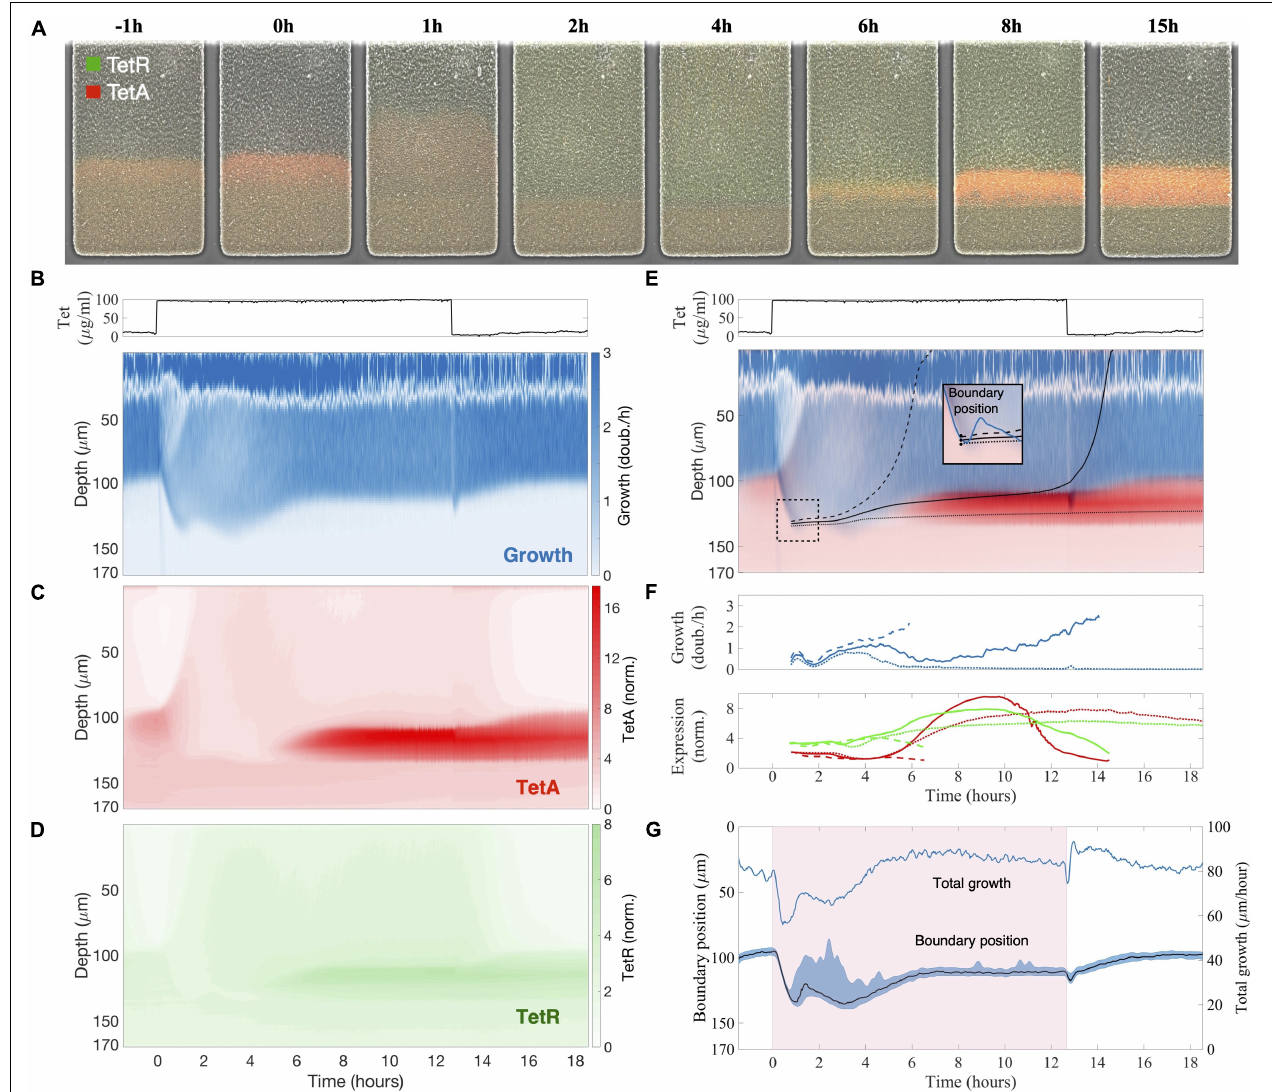
FIGURE 2 | Sudden exposure to tetracycline causes a reorganization of growth and expression patterns across the microcolony. (A) Images of the colony during a response to sudden exposure to tetracycline at time zero, with expression of repressor TetR shown in green and efflux pump TetA shown in red. Following exposure, growth arrest of cells near the surface makes nutrients available deeper into the trap, so the boundary between growing and arrested cells becomes diffuse. (B–D) Kymographs of (B) cell growth, (C) efflux pump TetA and (D) repressor TetR expression during a tetracycline response, a graphical representation of spatial position over time. Since neither cell growth nor gene expression vary substantially across the horizontal dimension of the trap, we calculate the average value of each measurement at each depth, at each timepoint. These average values are denoted by the color gradients in the kymographs. Cell growth is noisy near the top of the colony due to the difficulty in calculating velocities. Expression levels of TetA and TetR are normalized to basal expression levels, obtained from fast-growing cells in the absence of drug. Above, tetracycline concentration in the medium throughout the experiment, showing the period of exposure. (E) Single cell trajectories : Superimposed kymograph of cell growth (blue) and TetA expression (red), with black lines showing three approximate trajectories followed by single cells, calculated from the velocities. Inset: these cells are initially located near each other, by the boundary, shortly after the time of exposure, but later follow divergent paths. (F) Cell growth and expression of resistance genes TetR (green) and TetA (red) along these trajectories. (G) Boundary position follows the total growth of the colony. The period of exposure to tetracycline depicted in pink shading. Position of the boundary between growing and arrested cells during the drug response, defined as the depth of half-maximal growth at each timepoint (black line). The blue shading denotes the interval between 30 and 70% maximal growth at each time point. The total growth of the colony, defined as the integral of the growth across the whole depth of the trap, is simply the velocity of cells at the top of the trap (blue